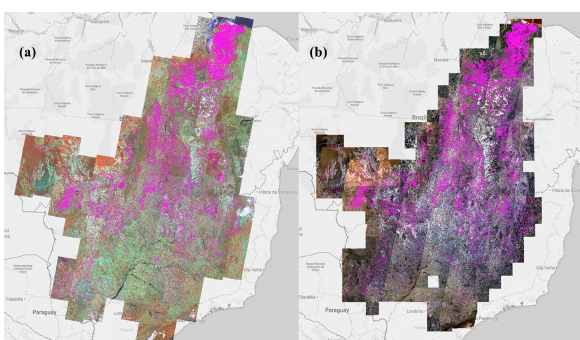
Figure 4. (a) PRODES-Cerrado deforestation polygons over the Landsat mosaic. (b) PRODES-Cerrado deforestation polygons over the Sentinel mosaics for the year of